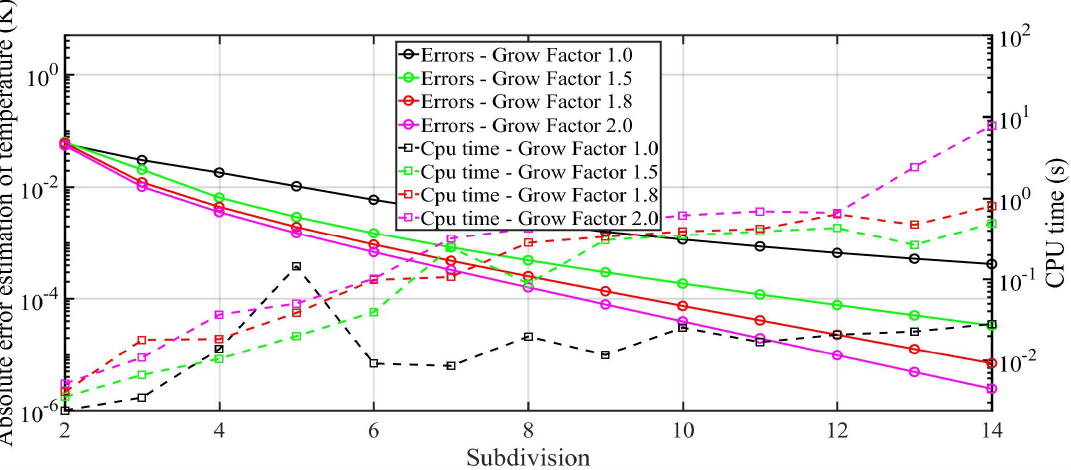
Figure 12. Absolute maximum temperature error estimations of the inner surface (Case 2).